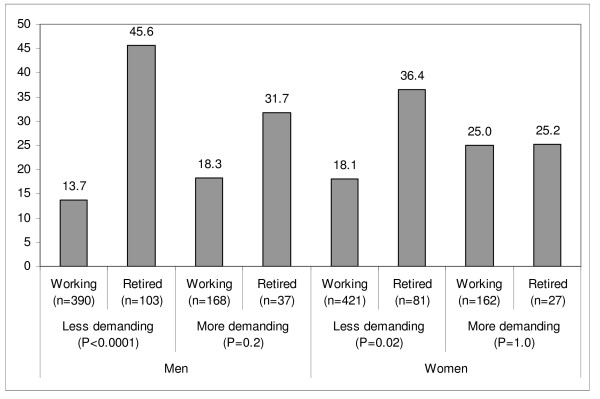
Three-year changes in time spent watching TV (min/day) according to initial physical demands at work1. 1Adjusted for age, education level and baseline time spent watching TV.